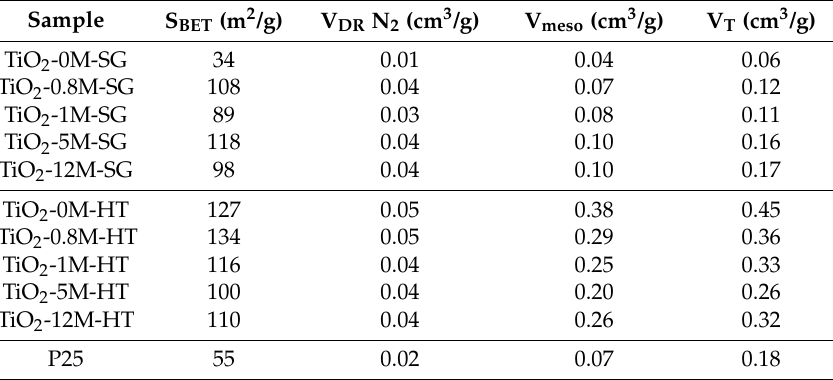
Table 1. Textural properties of the SG and HT series of samples. Sample